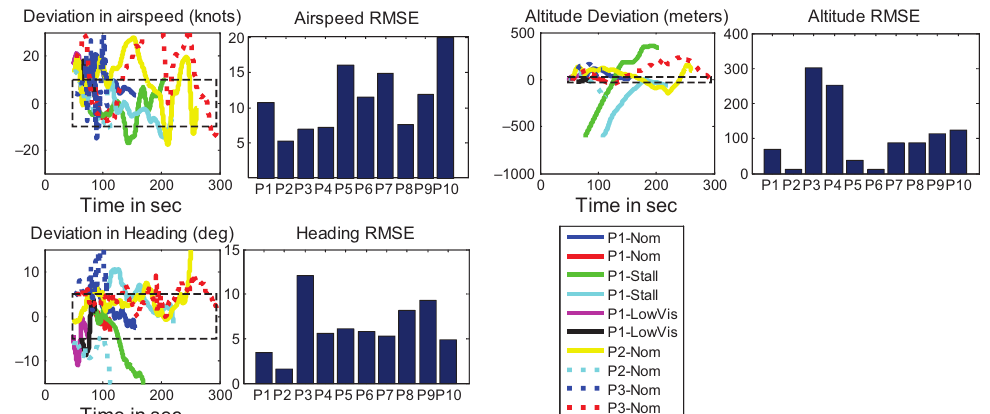
Figure 8. Error in the first level